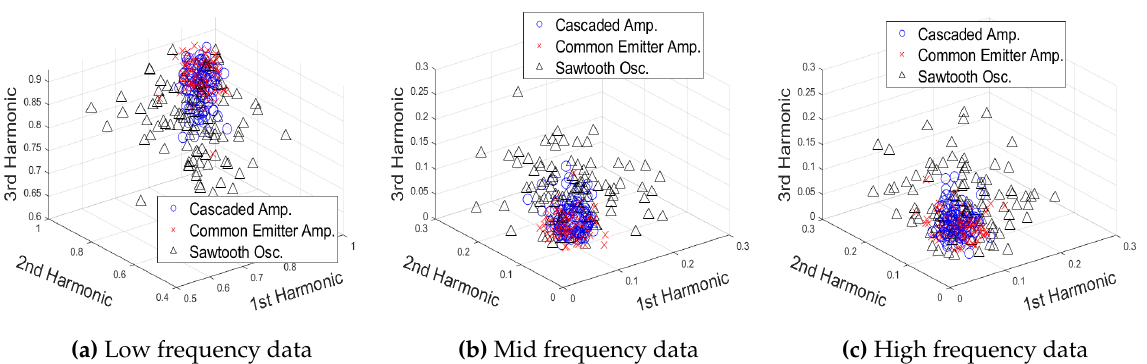
Figure 12. Scattered plots of Fourier features in 3D harmonic space, SNR=2 dB.